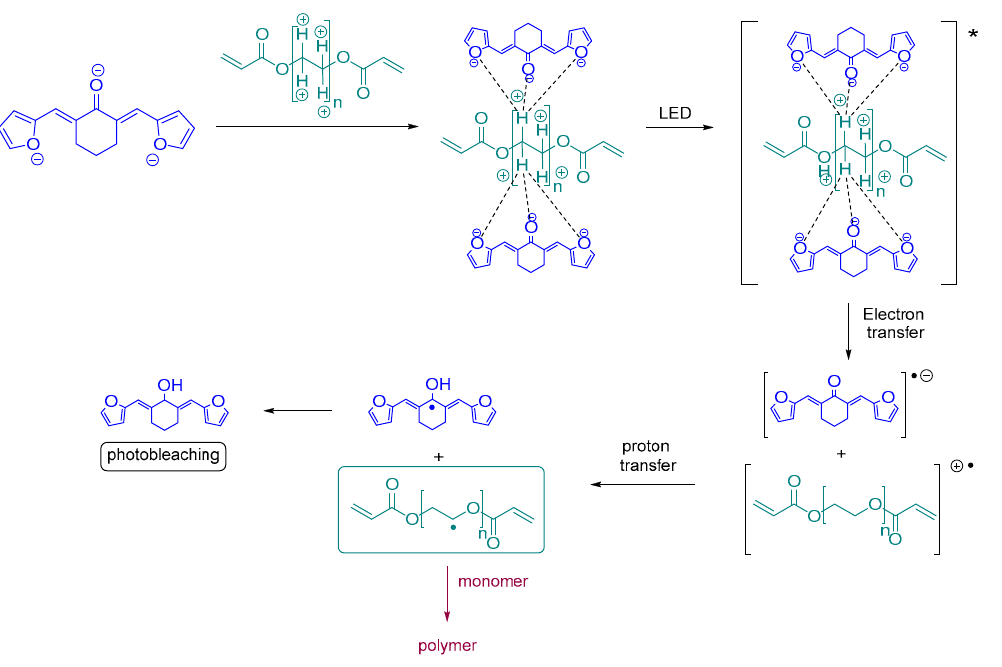
Scheme 2. Mechanism of photoinitiation and photobleaching with the BFC/PEGDA combination. (* corresponds to the excited dye).